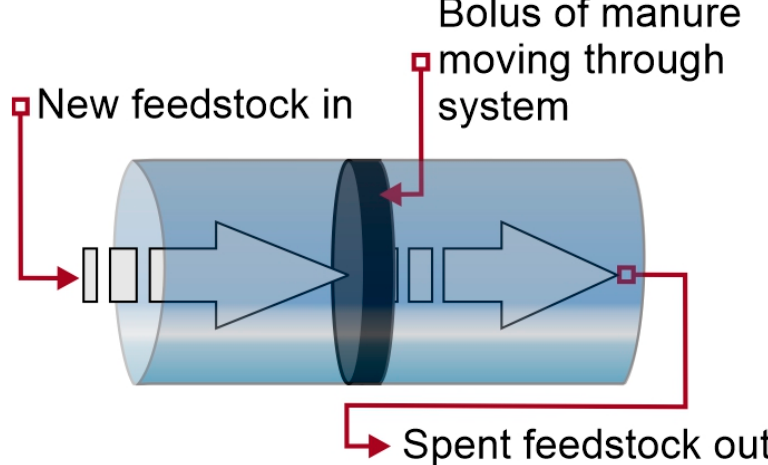
Figure 3. Plug-Flow Digester.